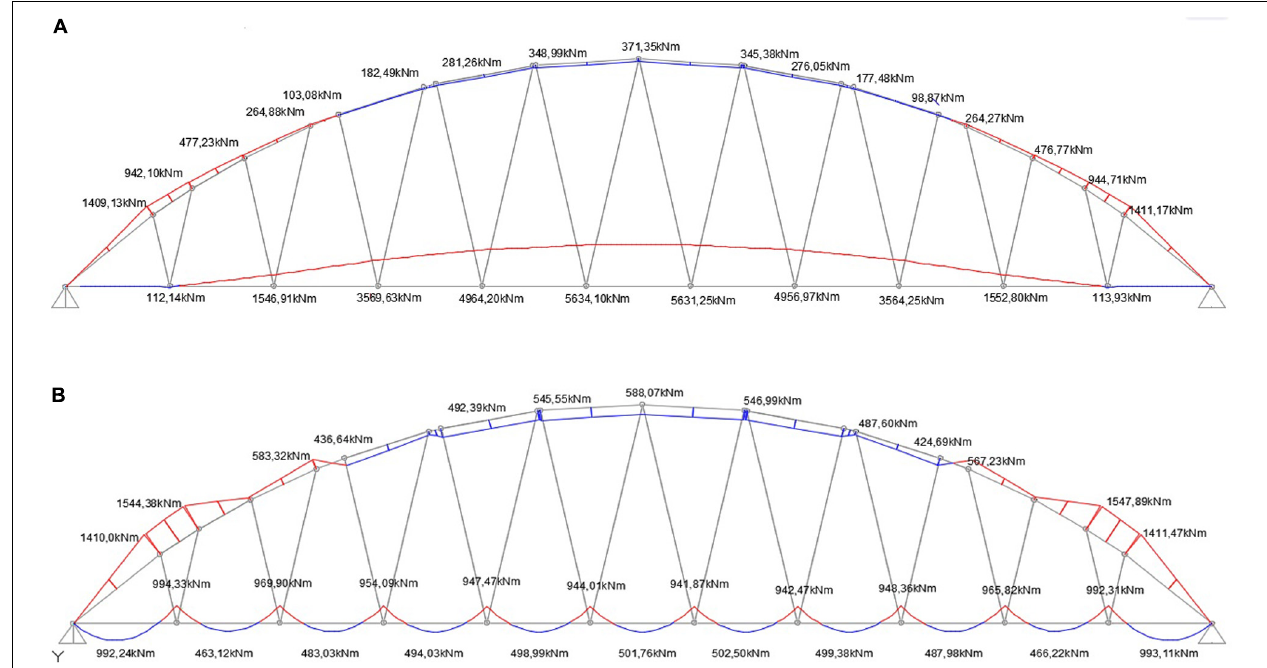
FIGURE 6 | Bending moment distributions for load case 1. (A) BMD produced by the action of the optimal cable pre-tension forces alone. (B) TBMD produced by the combined action of self-weight + optimal cable pre-tension forces.